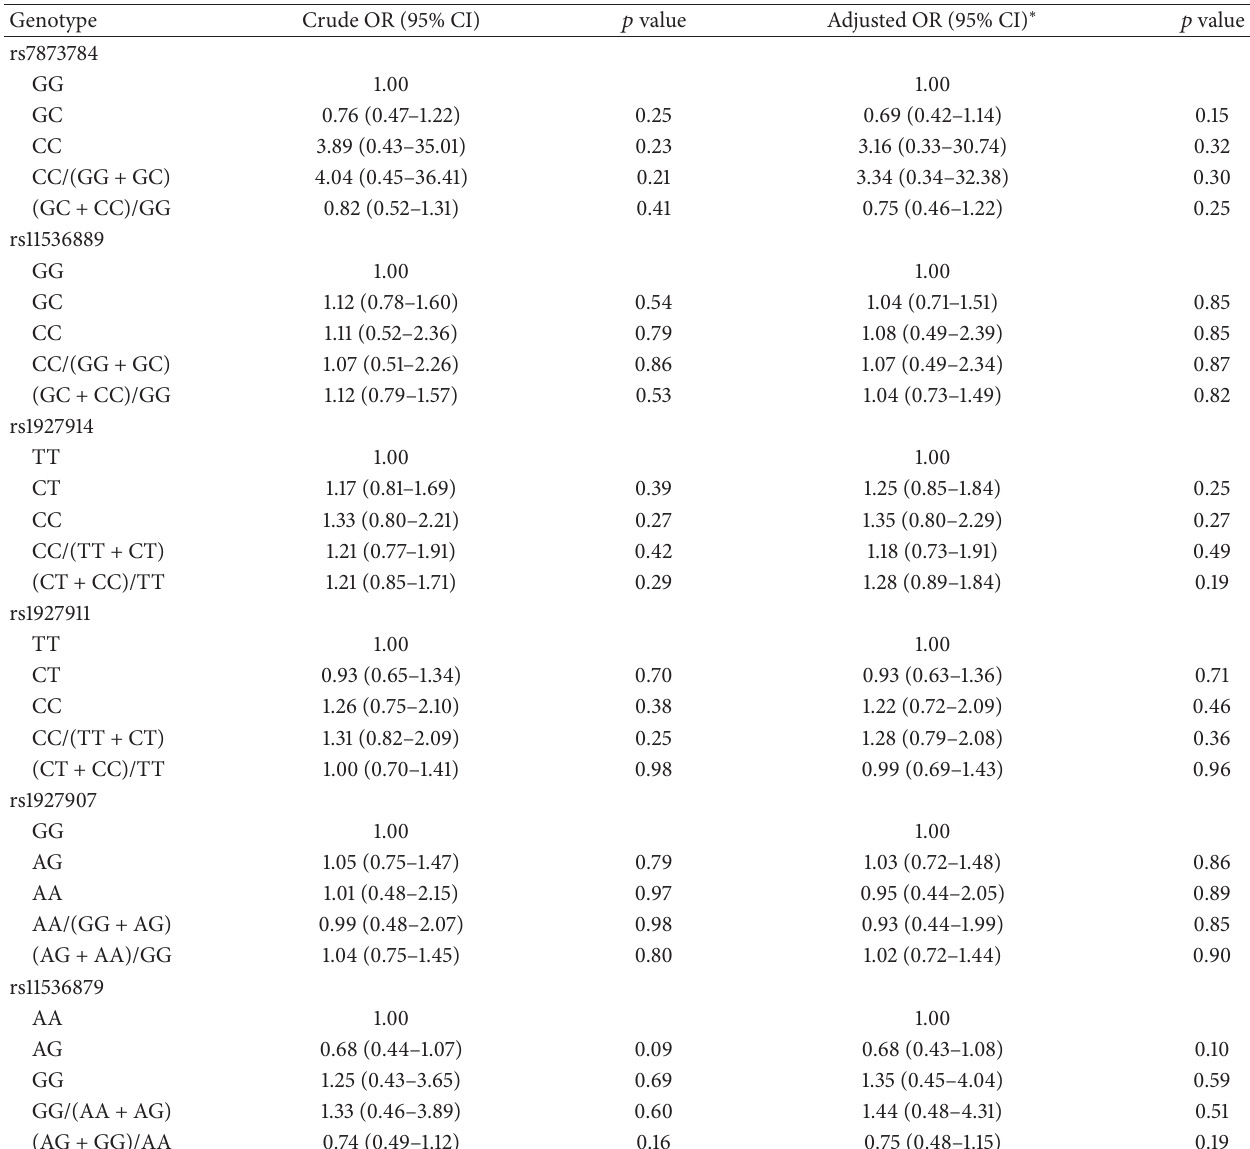
Table 5: Associations between the SNPs of TLR 4 and DMTB